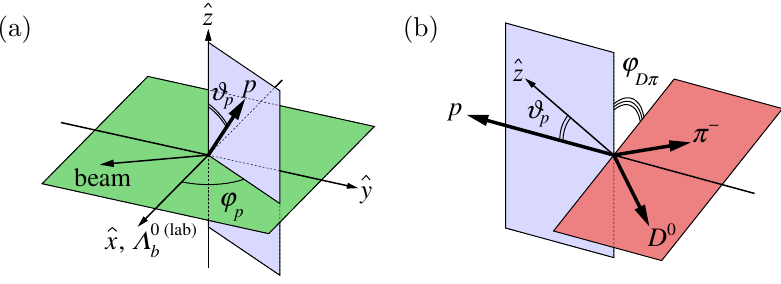
Figure 2 . De(cid:12)nition of the angles describing the orientation of the (cid:3) 0 reference frame where the (cid:3) 0 baryon is at rest: (a) # p and ’ p , and (b) ’ D(cid:25) b